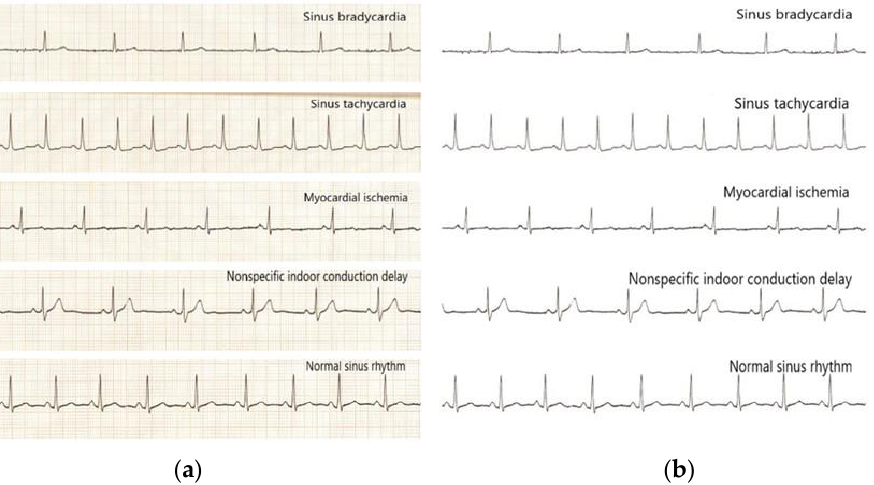
Figure 5. Images of the four typical abnormal categories and normal sinus rhythm before and after processing: ( a ) Before processing; ( b ) After processing.